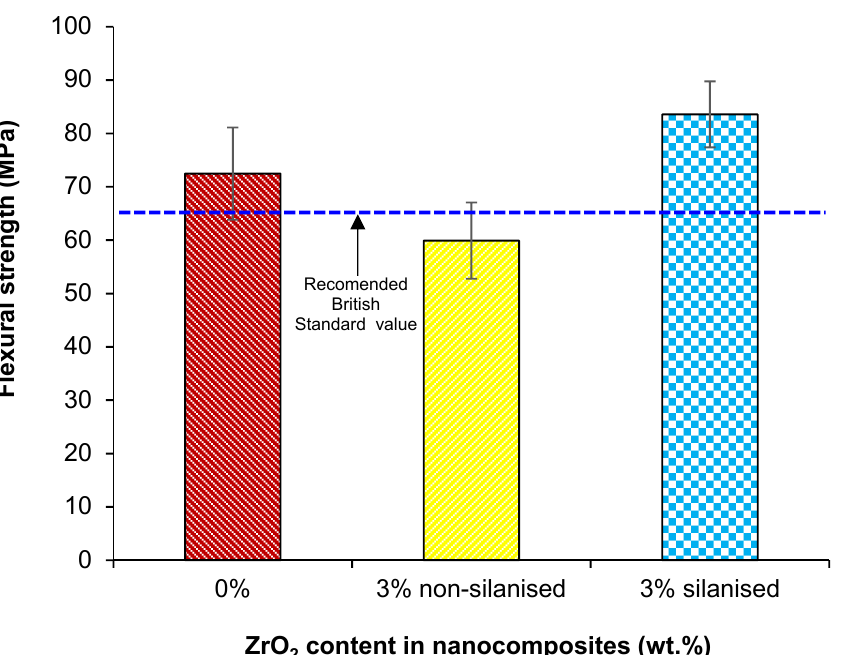
Figure 5. Bar charts showing the effect of treating zirconia nanoparticles on the flexural strength of PMMA-zirconia nanocomposites.